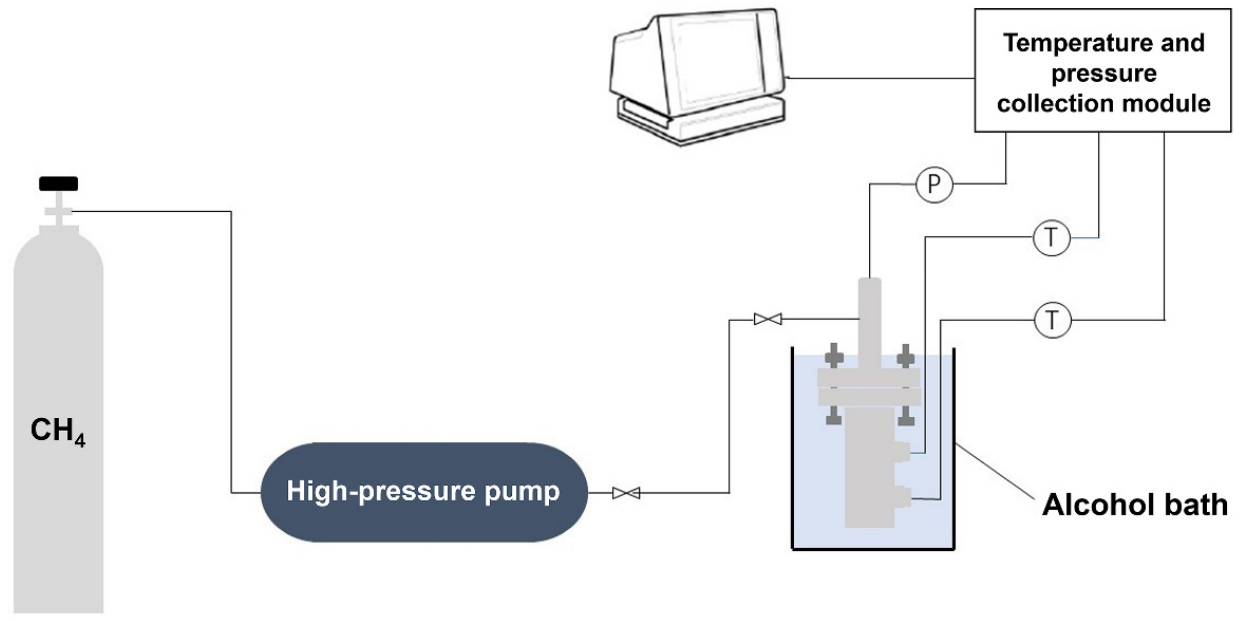
Figure 1. Schematic of experimental setup for the synthesis of methane hydrate and methane ad- sorption-desorption